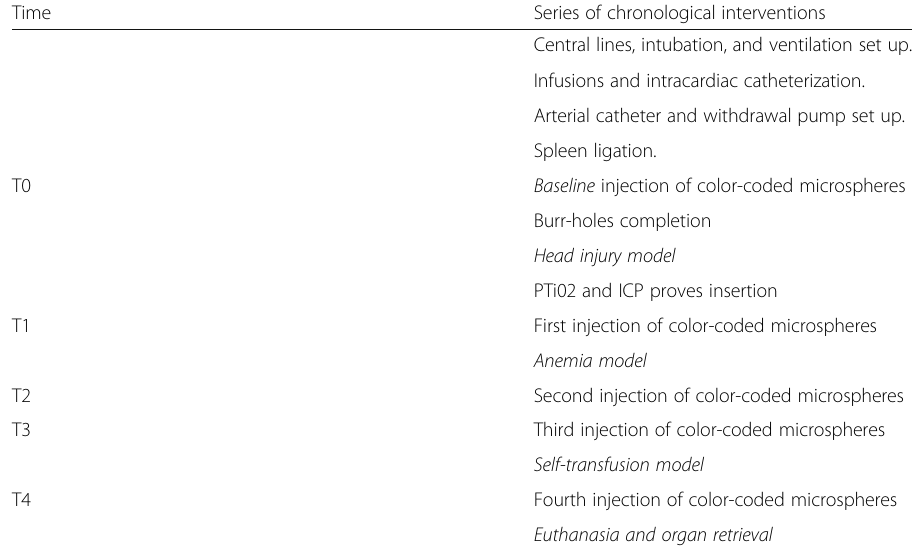
Table 1 Final study (4 and 5 of 5 studies) interventions distributed along different time points Time Series of chronological